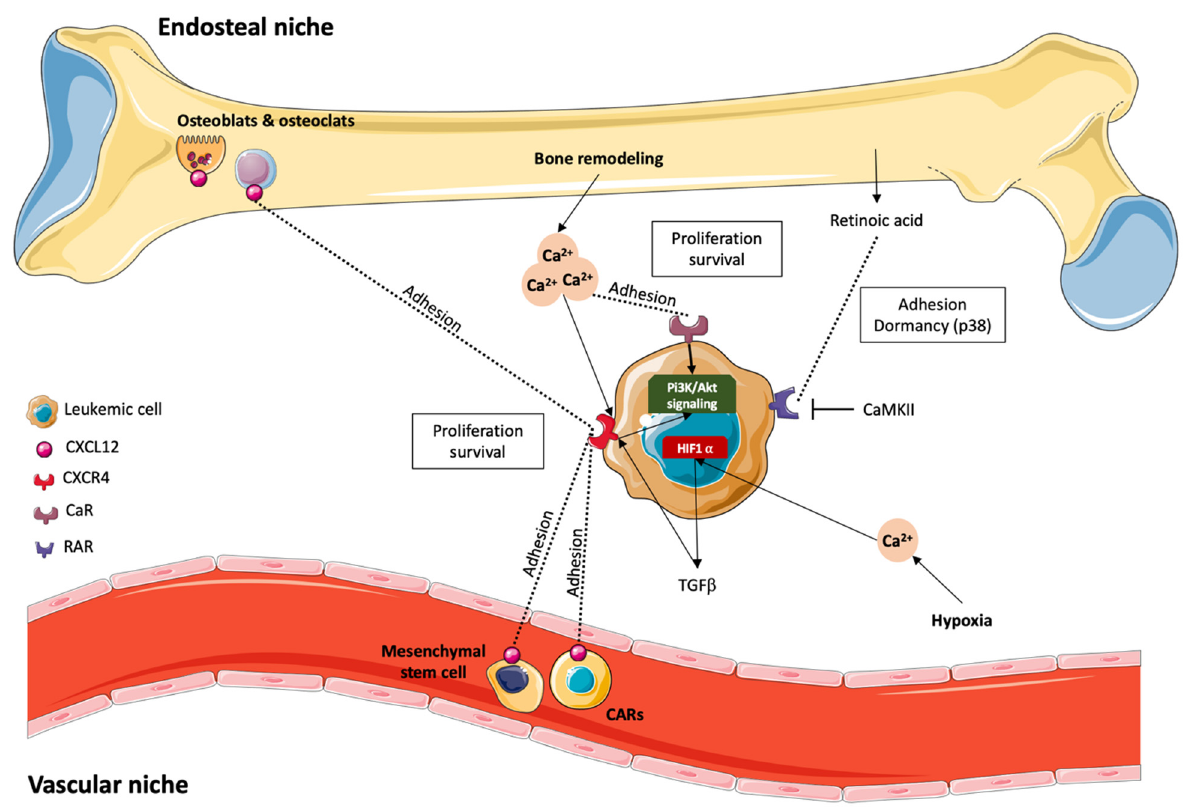
Figure 4. Mechanisms of adhesion to the niche. The binding of CXCL12 expressed by mesenchymal stromal cells, CARs, osteoclasts, and osteoblasts to CXCR4 expressed by leukemic stem cells induces an increase in intracellular calcium ion levels, leading to the entrance of LSCs into the vascular or endosteal niche, which in turn induces prosurvival and proliferative signaling pathway mobilization. Bone remodeling is responsible for the high extracellular calcium level, which enables the binding of calcium to the CaRs expressed by LSCs, thus helping the cells adhere to the niche. RA present in the BM microenvironment can bind to its RARs expressed on LSCs, inducing the regulation of LSC growth, proliferation, differentiation, apoptosis, and immune response; however, RAR activity can be modulated by CaMKII. The hypoxic environment of the BM seems to have proliferation-inducing and prosurvival effects on AML cells and upregulates CXCR4 expression on blasts, allowing them to adhere to the